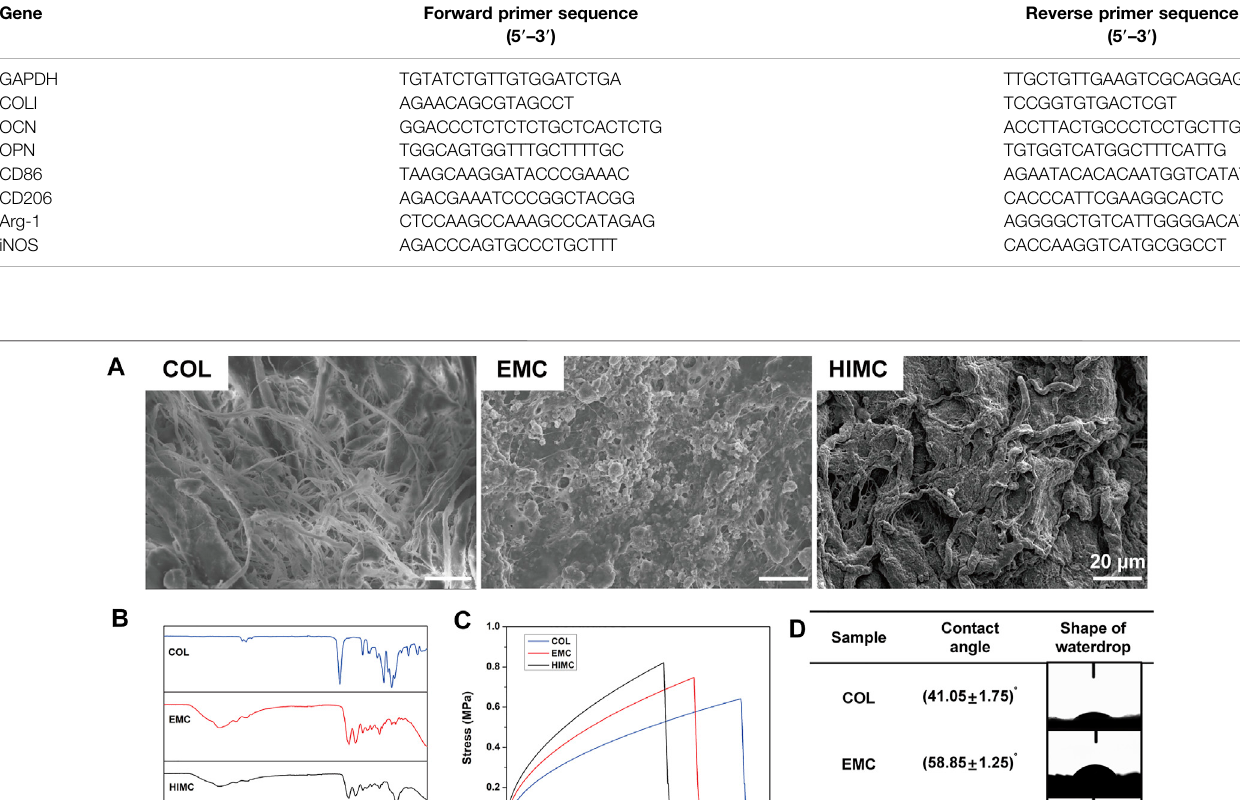
Frontiers in Bioengineering and Biotechnology |